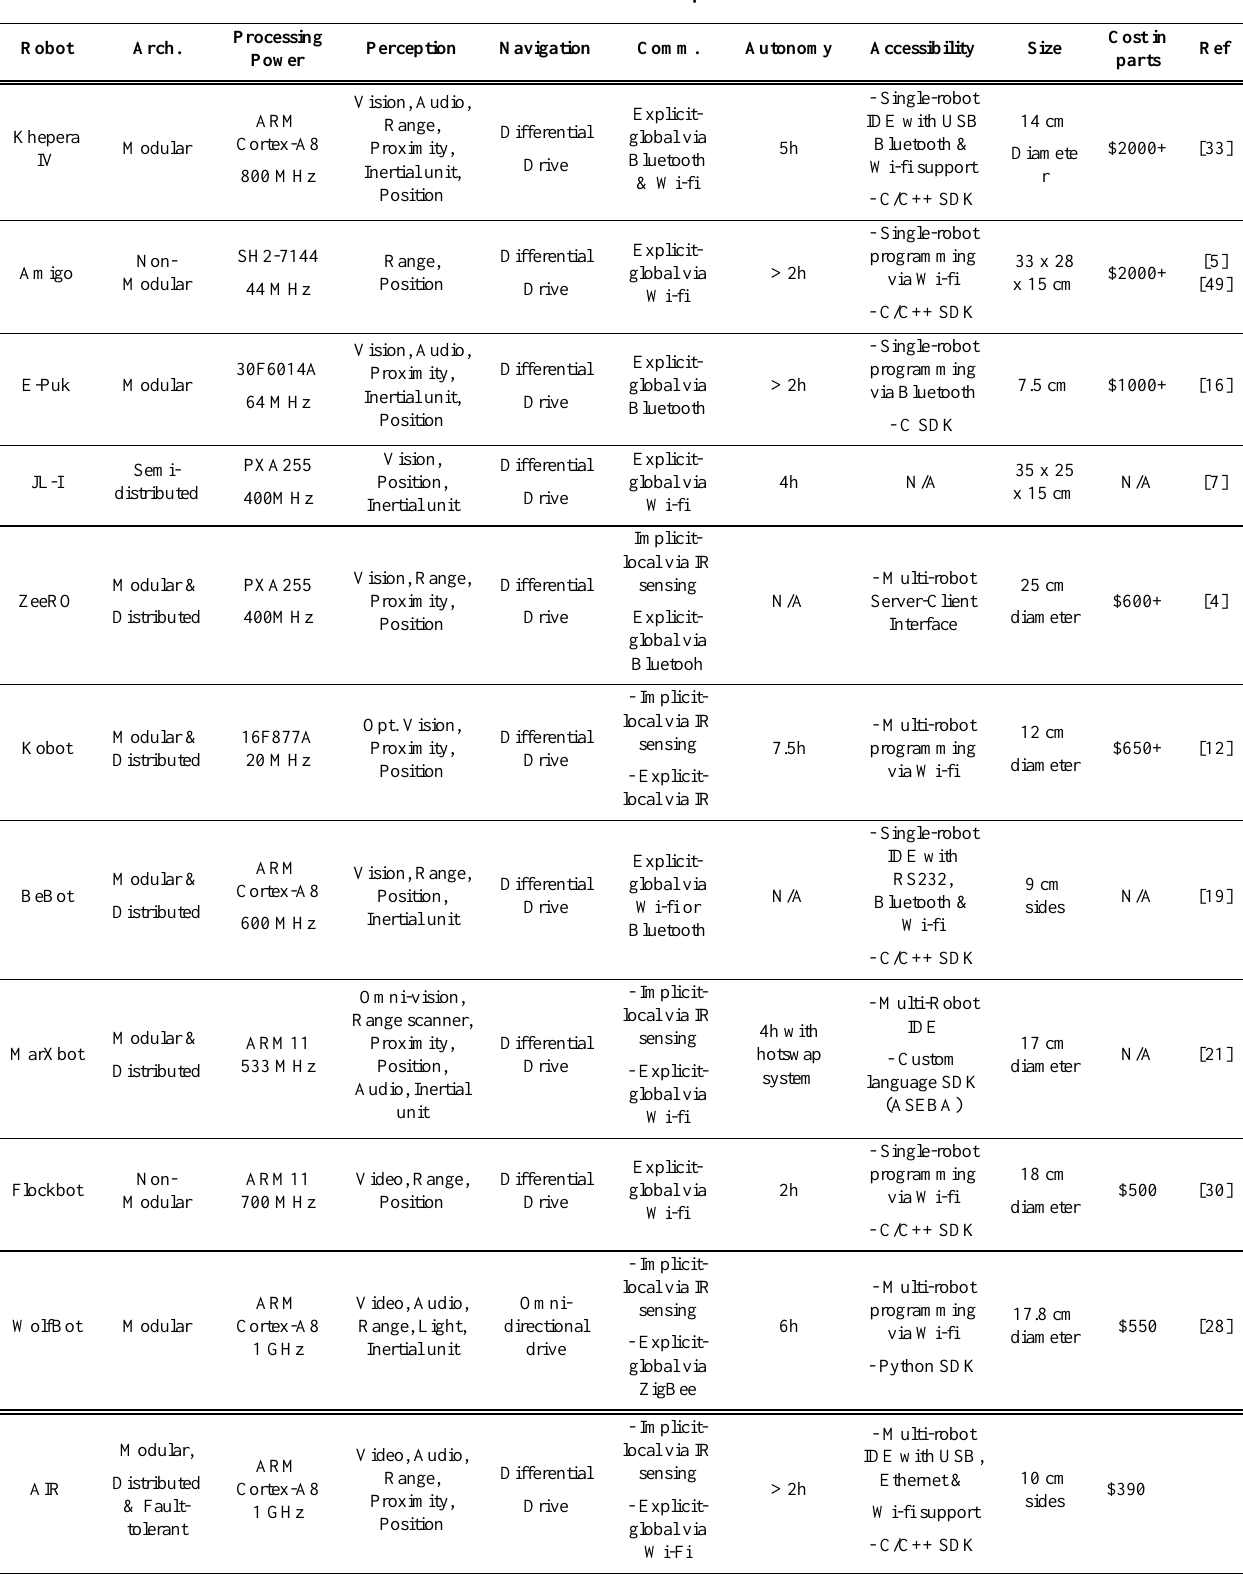
Table 3. Platform